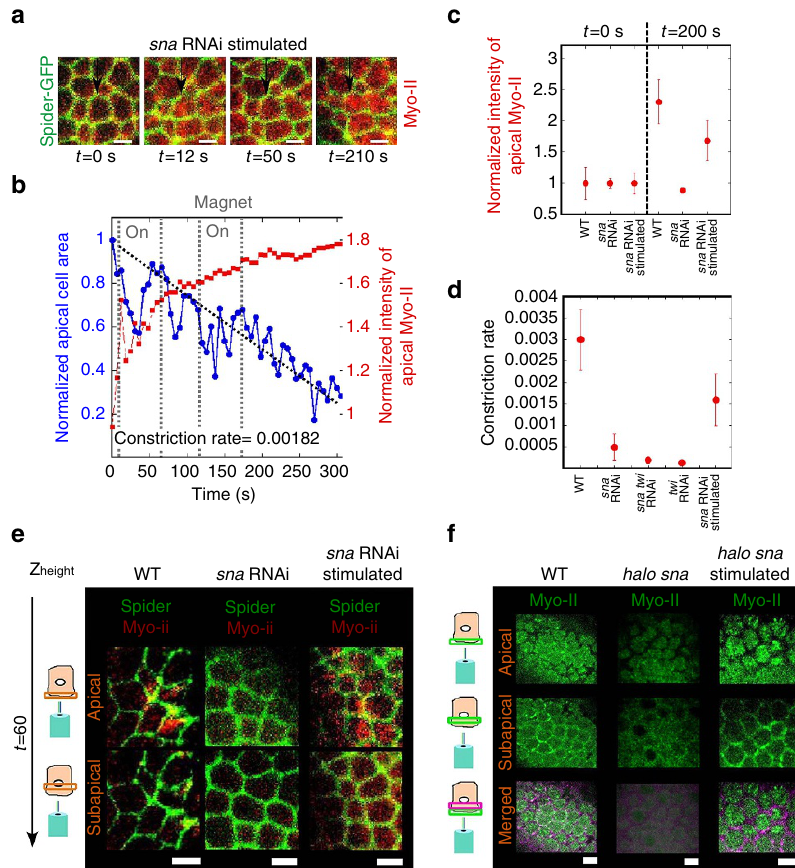
Figure 3 | Rescue of medio-apical Myo-II in sna -defective embryos by mechanical pulses. ( a ) Dynamical imaging of apex size (Spider, Gilgamesh in green) and accumulation of Myo-II (1 m m below, merged in red) in sna RNAi-injected embryos in magnetically stimulated embryos mimicking sna -dependent pulsations in mesoderm cells. Representative of n ¼ 3 of the N ¼ 5 embryos ( P ¼ 0.015, exact Fisher test). ( b ) Quantification on one representative cell of a . ( c ) Quantification of the apical accumulation of Myo-II at 200s compared with 0s in the WT, sna RNAi and sna RNAi magnetically stimulated. N ¼ 6 embryos for each condition ( P o 10 (cid:2) 3 for both sna RNAi versus WTand sna RNAi magnetically stimulated). ( d ) Constriction rate in WT ( N ¼ 6), versus sna RNAi-injected ( N ¼ 6, P ¼ 0.004), sna RNAi twi RNAi-injected ( N ¼ 6, P ¼ 0.02), twi RNAi ( P ¼ 0.002) and sna RNAi magnetically stimulated ( N ¼ 4, P ¼ 0.03) embryos. Scale bars, 5 m m. P values are calculated from the Mann–Whitney test, and error bars are s.e. ( e ) Spider (Gilgamesh, in green) and Myo-II (in red) cortical submembrane and junctional apical locations in the mesoderm cells of WT, sna RNAi and sna RNAi magnetically stimulated embryos, at t ¼ 100s. ( f ) Myo-II (in green) cortical submembranar and junctional apical locations in the mesoderm cells of WT, halo sna and halo sna magnetically stimulated embryos, at t ¼ 100s. Representative of n ¼ 8, n ¼ 8 ( P o 10 (cid:2) 3 , exact Fisher test) and n ¼ 6 embryos ( P ¼ 7 (cid:3) 10 (cid:2) 3 ) respectively, of the N ¼ 8 embryos observed in each